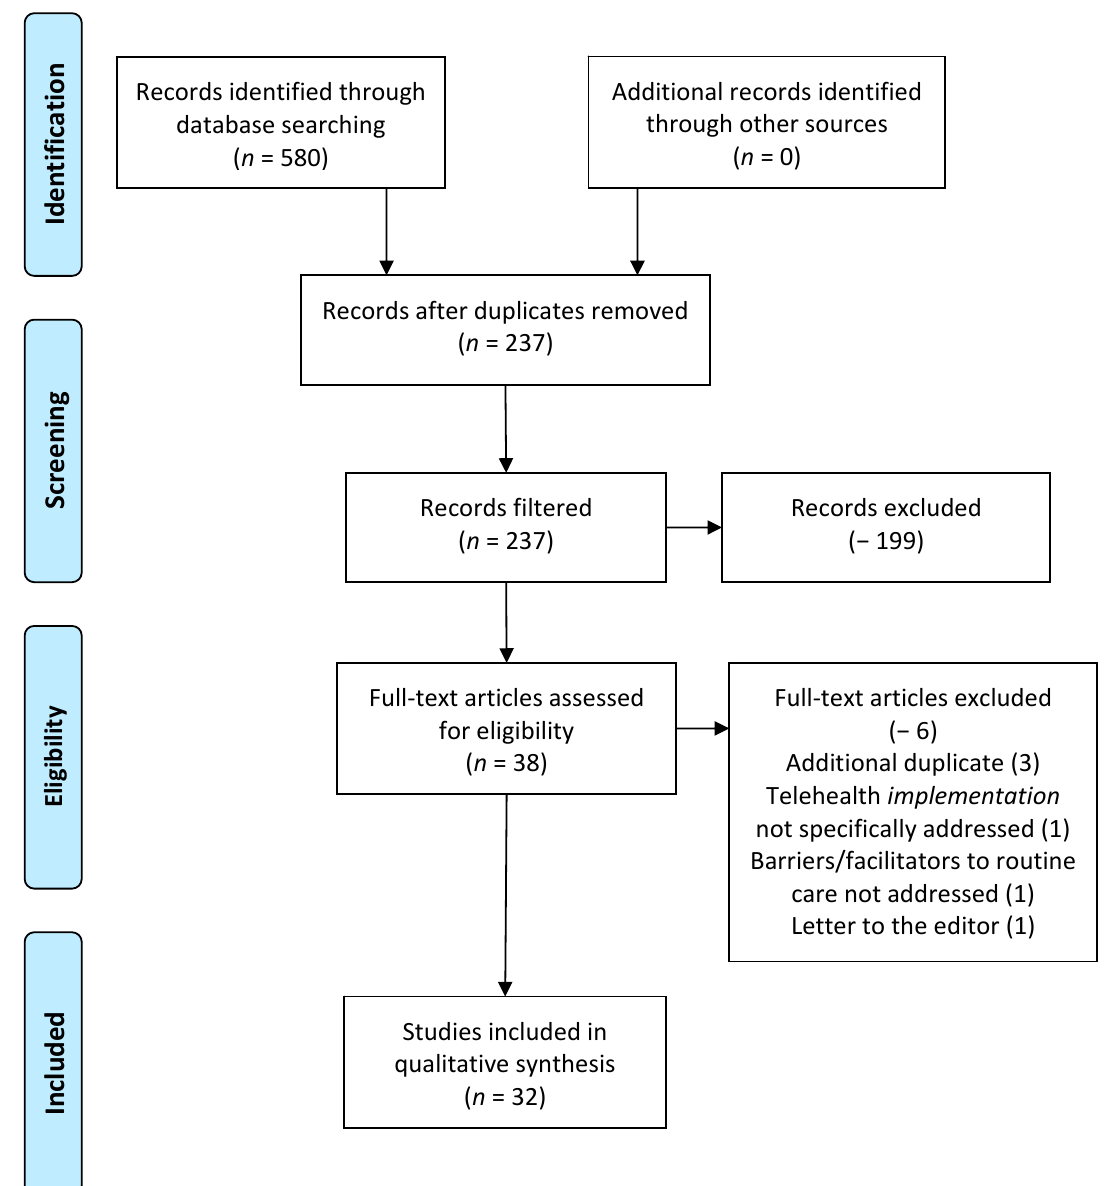
Figure 1. Preferred reporting items for systematic reviews and meta-analysis (PRISMA) figure that demonstrates the study selection process.